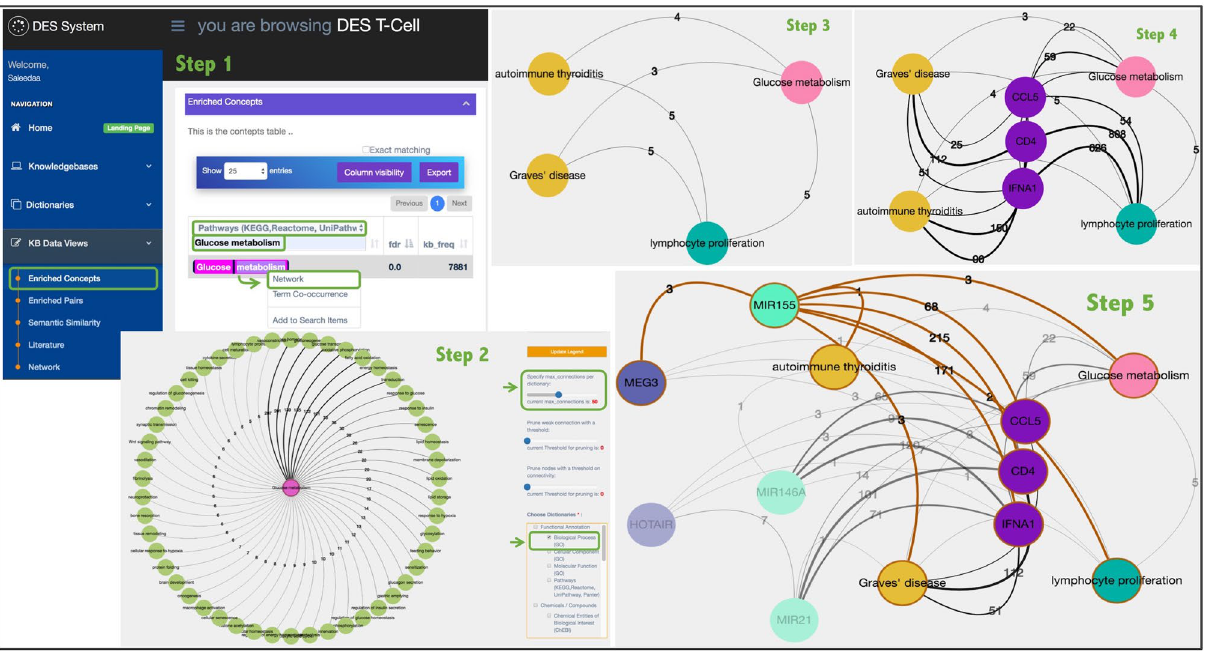
Figure 3. Step-by-step illustration of how DES-Tcell can be used to explore potentially new therapeutic targets for Graves’